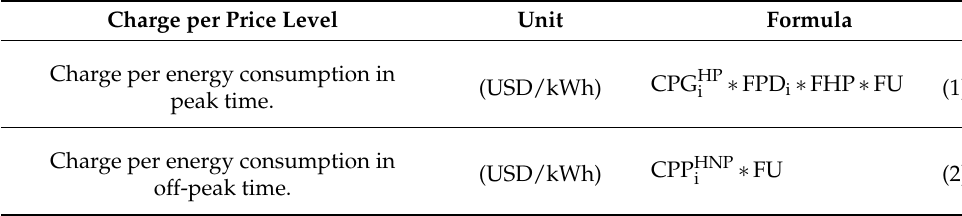
Table 5. Tariff formulas for residential TOUP options.